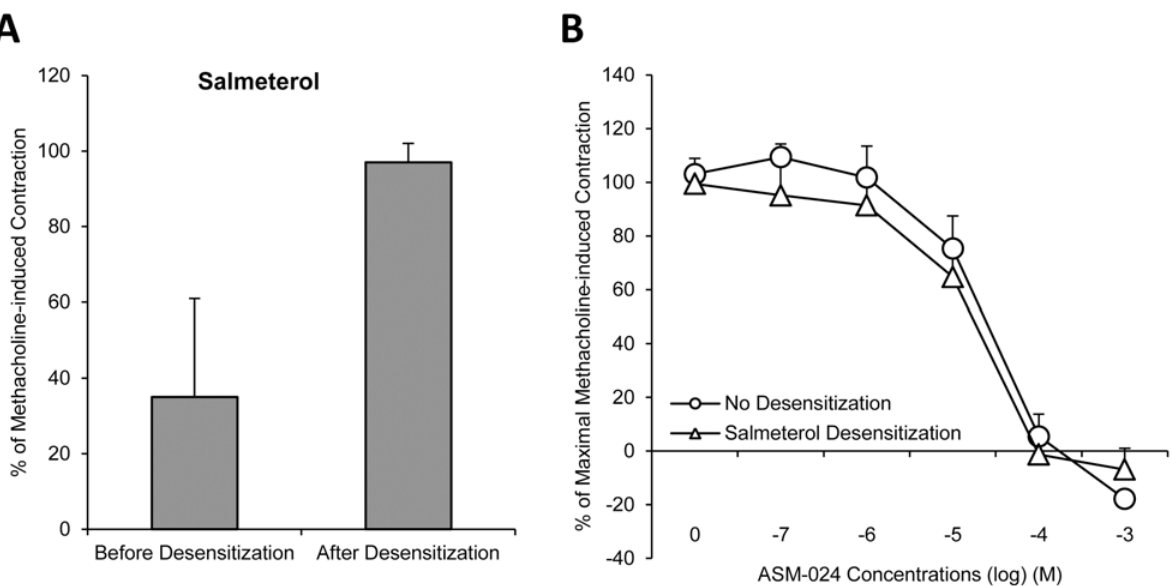
Fig 3. Relaxant Effects of ASM-024, on Salmeterol Desensitized Guinea-Pig Tracheas. A) Intact guinea pig tracheas were studied before and after 4 h of exposure to the long acting β 2 agonist salmeterol. A reduced relaxation response to salbutamol is observed after 4 hour exposure to salmeterol (p < 0.05). B) No significant difference was observed on the relaxation response curves of ASM-024 on intact or salmeterol desensitized tracheas. n = 4.